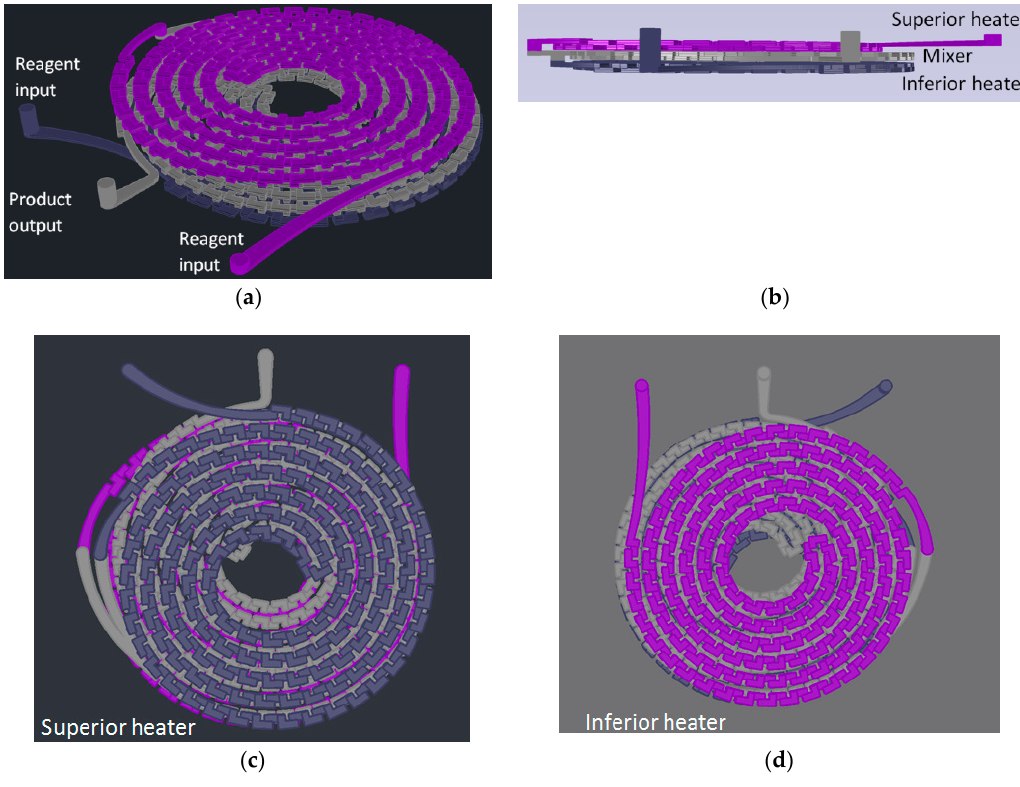
Figure 14. Design of a reactor for synthesis of gold nanoparticles by the Turkevich method. ( a ) Perspective view; ( b ) Frontal View; ( c ) Top view; ( d ) Bottom view.